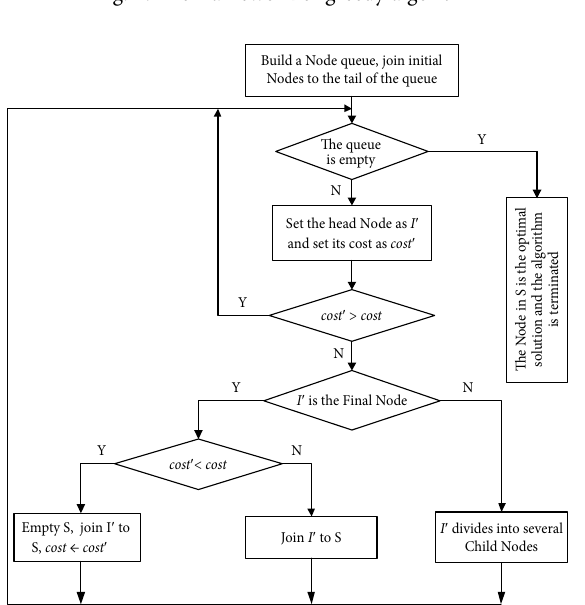
Fig. 5. The framework of dynamic